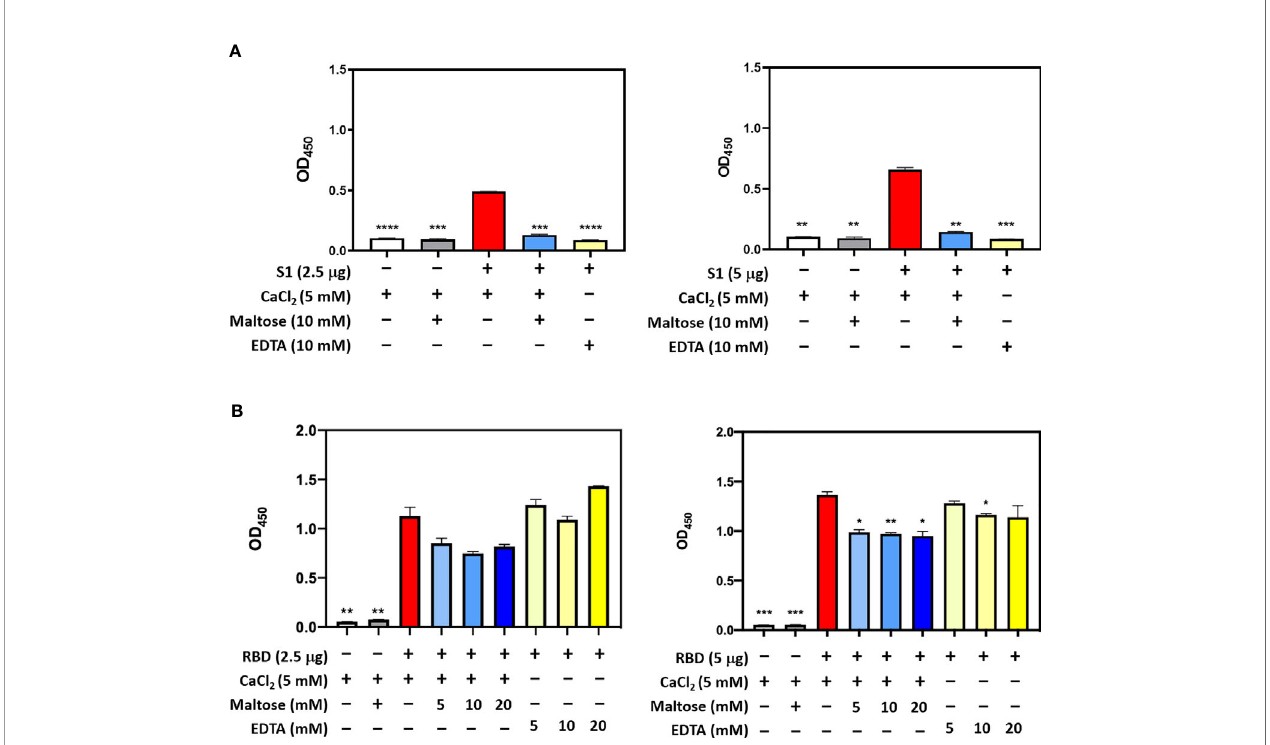
FIGURE 2 | Competitive ELISA to show the impact of Maltose and EDTA on rfhSP-D binding to S1 (A) and its RBD (B) . Polystyrene microtiter plates were coated with 2µg/ml rfhSP-D, and incubated with SARS-CoV-2 spike S1 protein (2.5 and 5 µg/ml) (sheep-IgG tag) or RBD (His-tag) (2.5 and 5 µg/ml). The binding was detected using anti-sheep IgG HRP antibodies (1:2000) or anti-His antibodies (1:2000). Absorbance at 450nm were recorded by VersaMax ™ ELISA Microplate Reader. Signi fi cance was determined using the unpaired t test statistical analysis. The error bars show SEM. All group compared to RBD in CaCl 2 (*p < 0.05; **p < 0.01; ***p < 0.001; ****p <